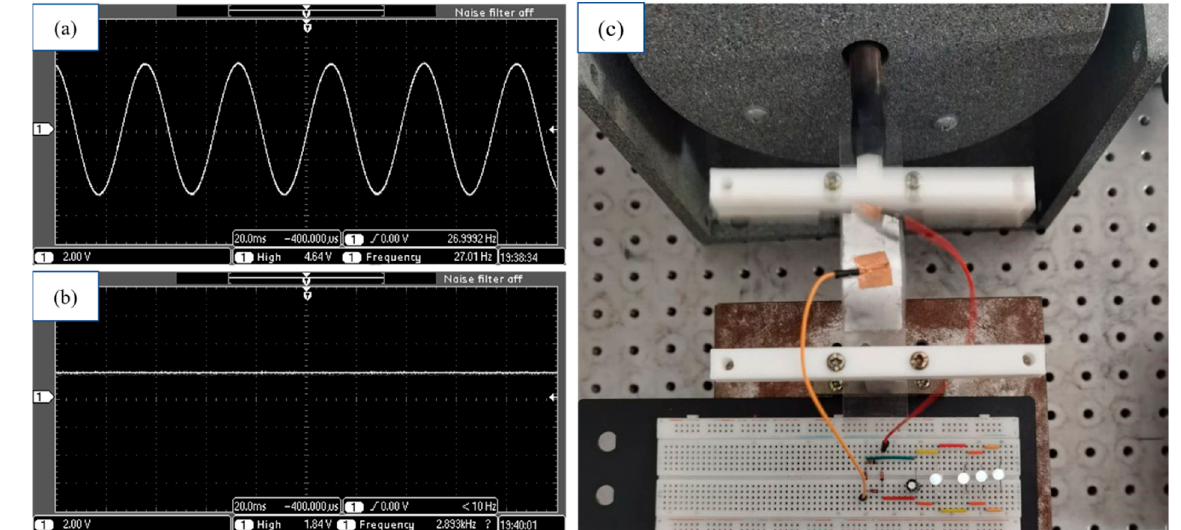
Figure 17. ( a ) and ( b ) are waveforms before and after rectification captured by the oscilloscope, ( c ) applications of the energy harvester to power up LEDs.